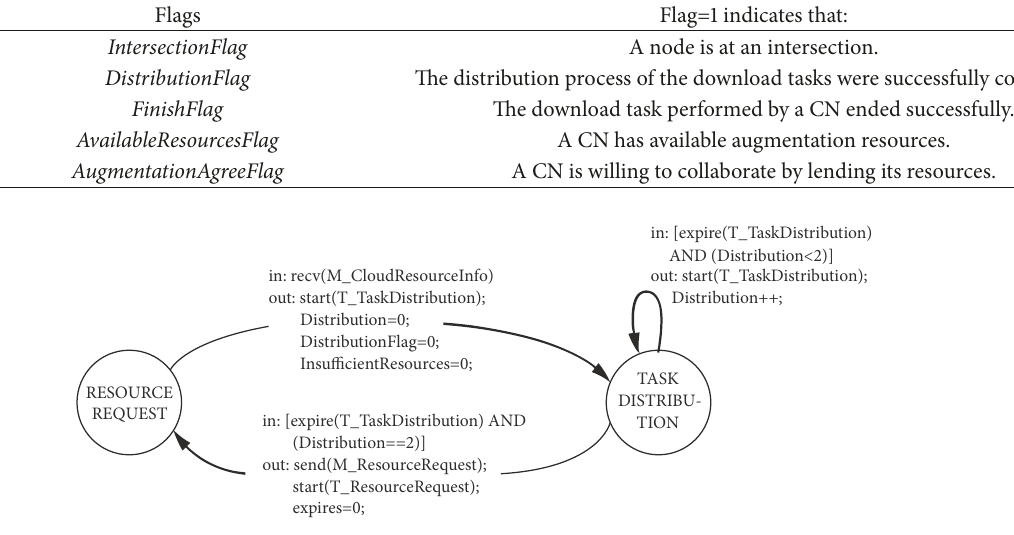
Figure 5: Transition from RESOURCE REQUEST to TASK DISTRIBUTION.